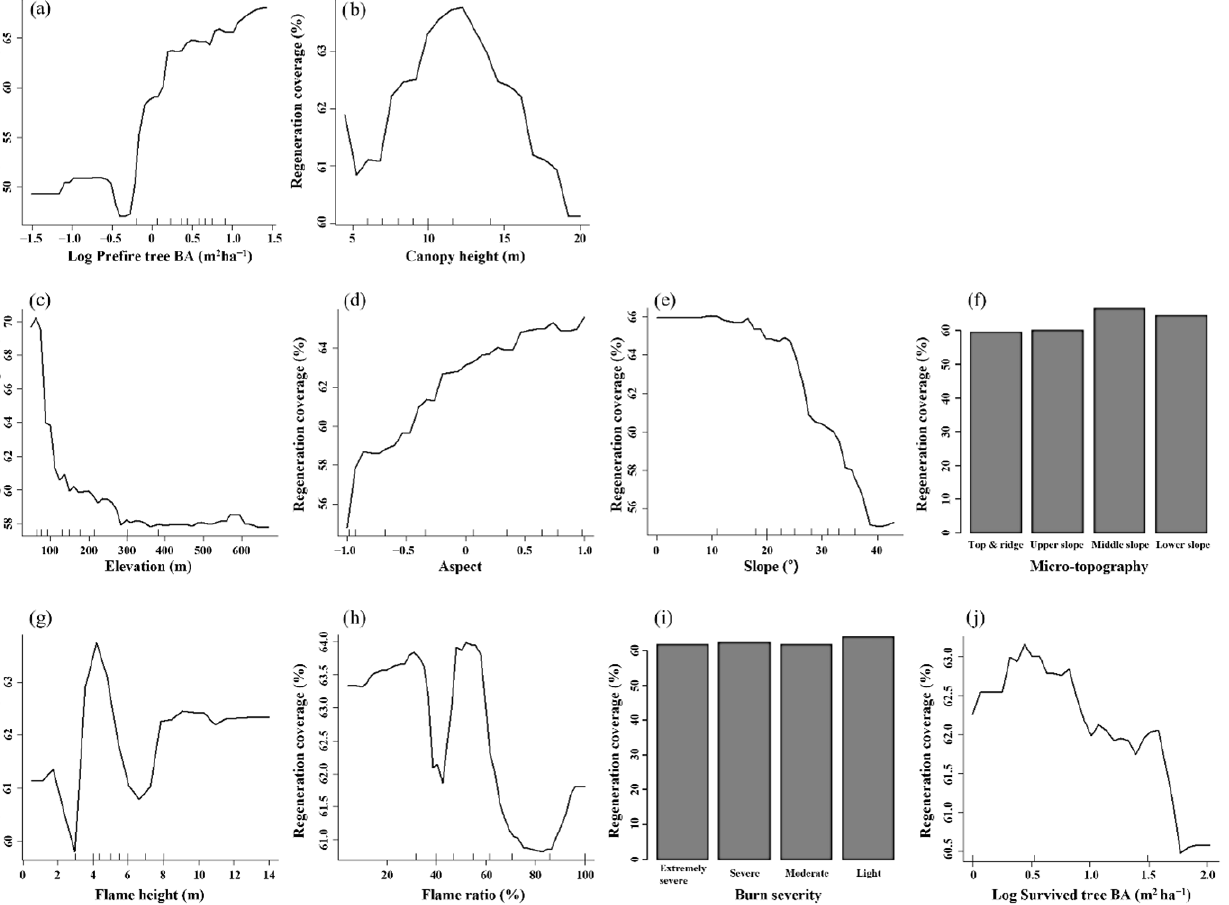
Figure 7. Partial-dependence plots of ten variables of fire, site, and prefire forest factors on the postfire regeneration coverage. Prefire forest-related variables are shown in the first row ( a , b ), site-related variables in the second row ( c – f ), and fire-related variables in the third row ( g – j ).